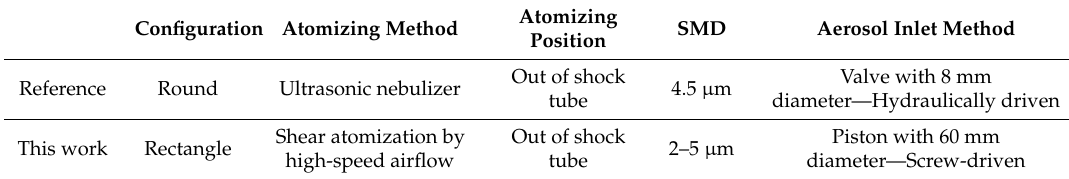
Table 2. Differences between two kinds of aerosol shock tubes. Table 2. Di ff erences between two kinds of aerosol shock